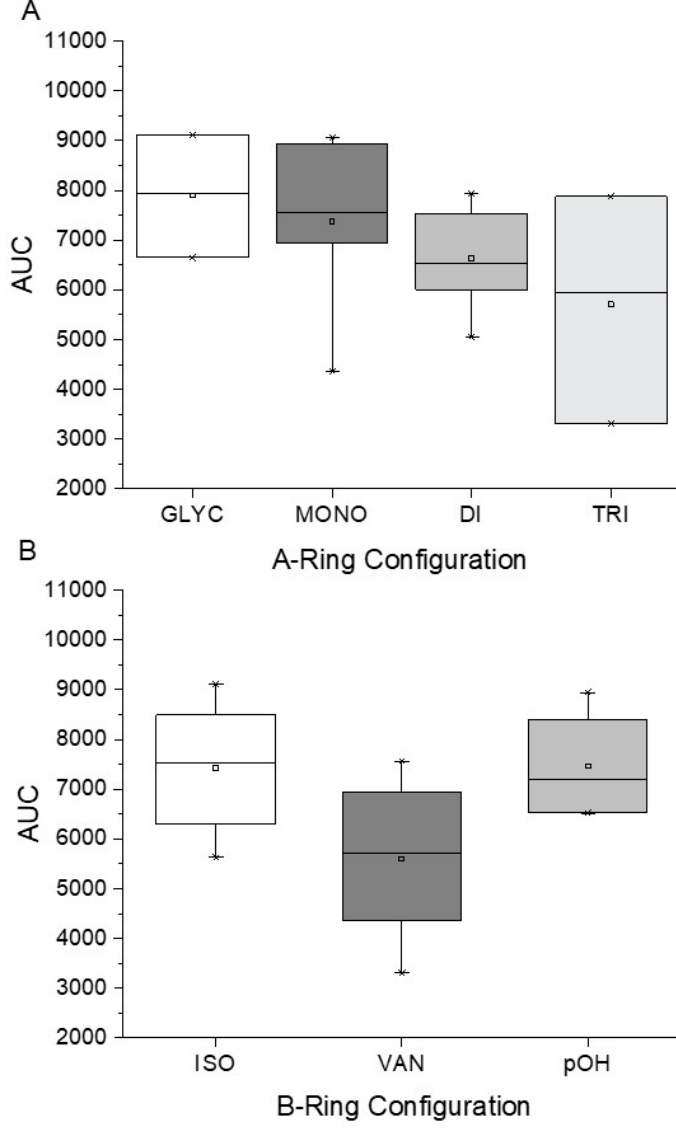
Figure 3. Clustering of compounds 1 – 18 according to structural similarity of ( A ) configuration on the A-ring, with glycoslated ( n = 3; 1 – 3 ), monohydroxylated ( n = 2; 12 and 13 ), dihydroxylated ( n = 8; 5 , 9 – 11 , 14 , 16 , and 17 ), and trihydroxylated ( n = 8; 1 – 4 , 6 – 8 , 15 ) and ( B ) configuration on the B-ring, with isovanilloyl ( n = 9; 1 – 4 , 6 , 11 , 15 , and 16 ), vanilloyl ( n = 6; 7 , 10 , 12 – 14 , and 17 ), and p-hydroxy benzyl ( n = 4; 5 , 8 , 9 , and 18 ) moiety. Depicted are box-plots (min, Q 0.25 , median, Q 0.75 , max) of the respective group